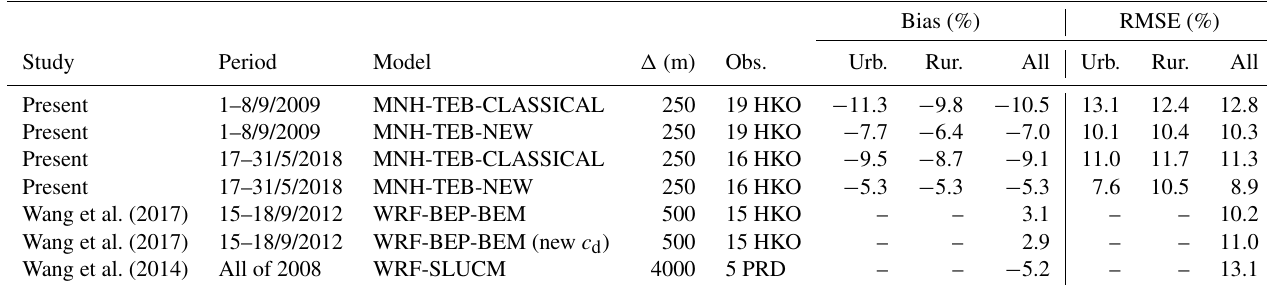
Table 4. Same as Table 3 but for relative humidity.